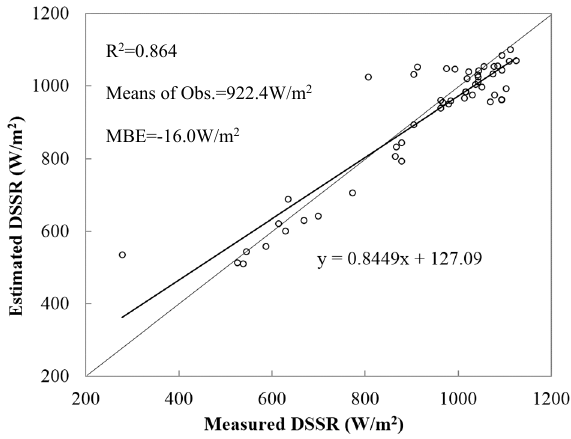
Figure 3. Scatterplots of the estimated solar radiation vs. the corresponding ground-based measurements and statistical results.